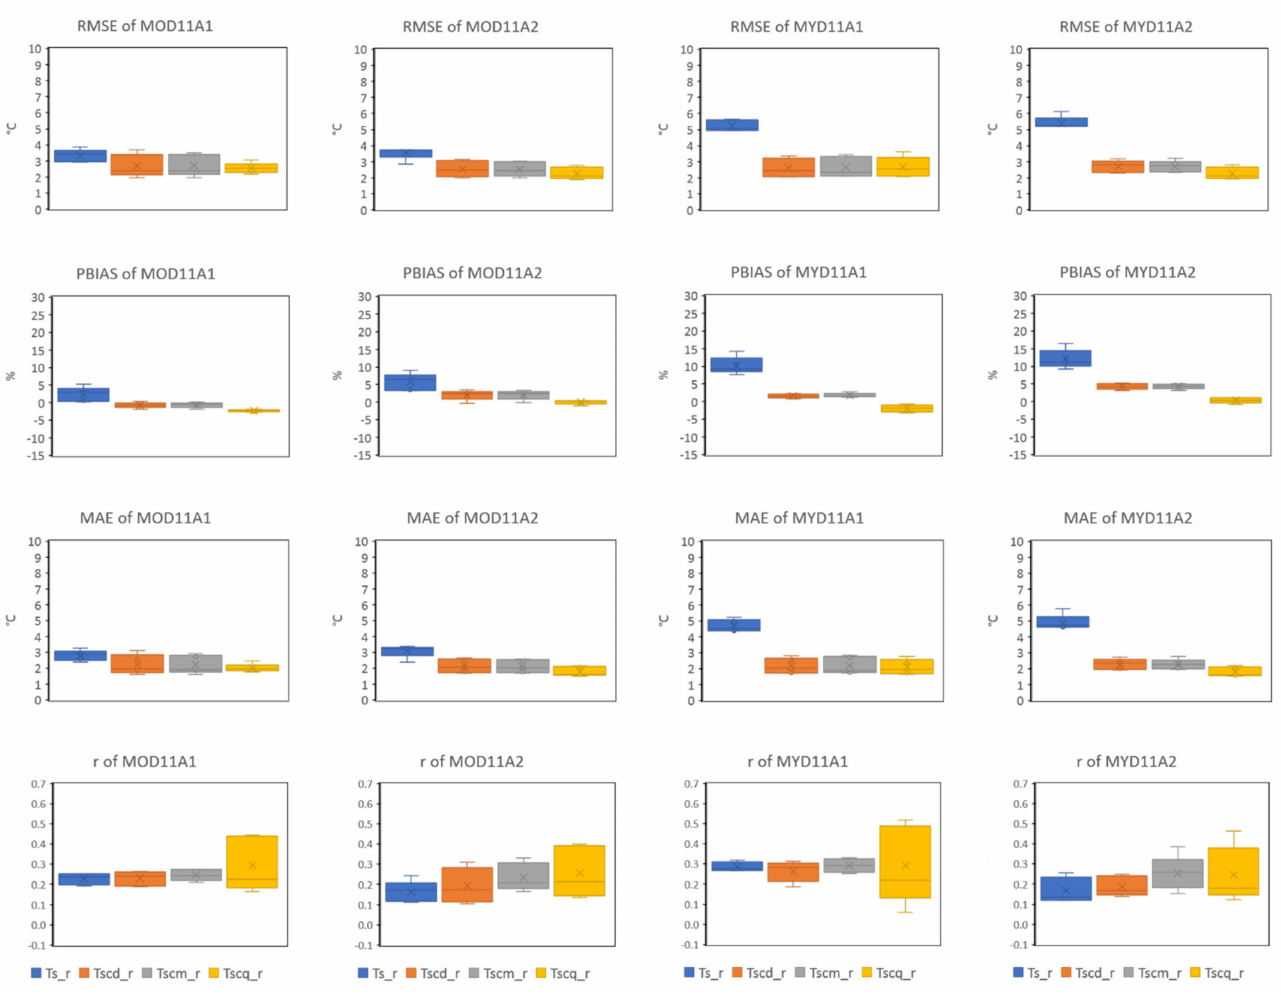
Figure 13. Comparison of evaluation metrics score between T s_r , T scd_r , T scm_r , and T scq_r against T a_r